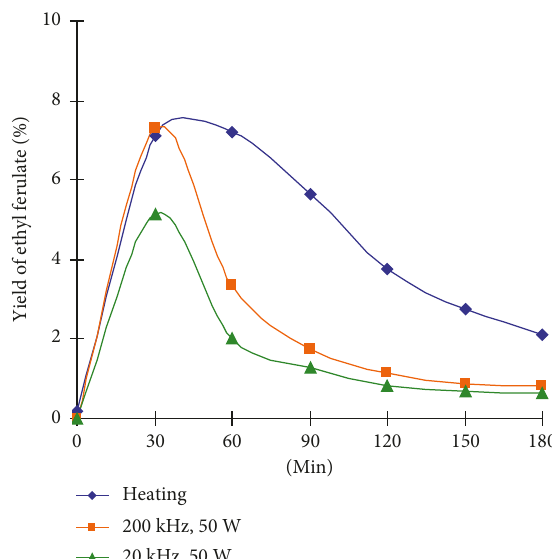
Figure 2: Behavior of ethyl ferulate produced as an intermediate under hydrolysis of c -oryzanol by the heating method and ultrasonic irradiation of 20 kHz and 200kHz with power of 50W at 50 ° C. Reaction conditions: initial concentration of c -oryzanol of 6mg/mL, KO ratio of 20:1 (wt/wt), and homogeneous system of Type A (ethyl acetate/H 2 O/ethanol)